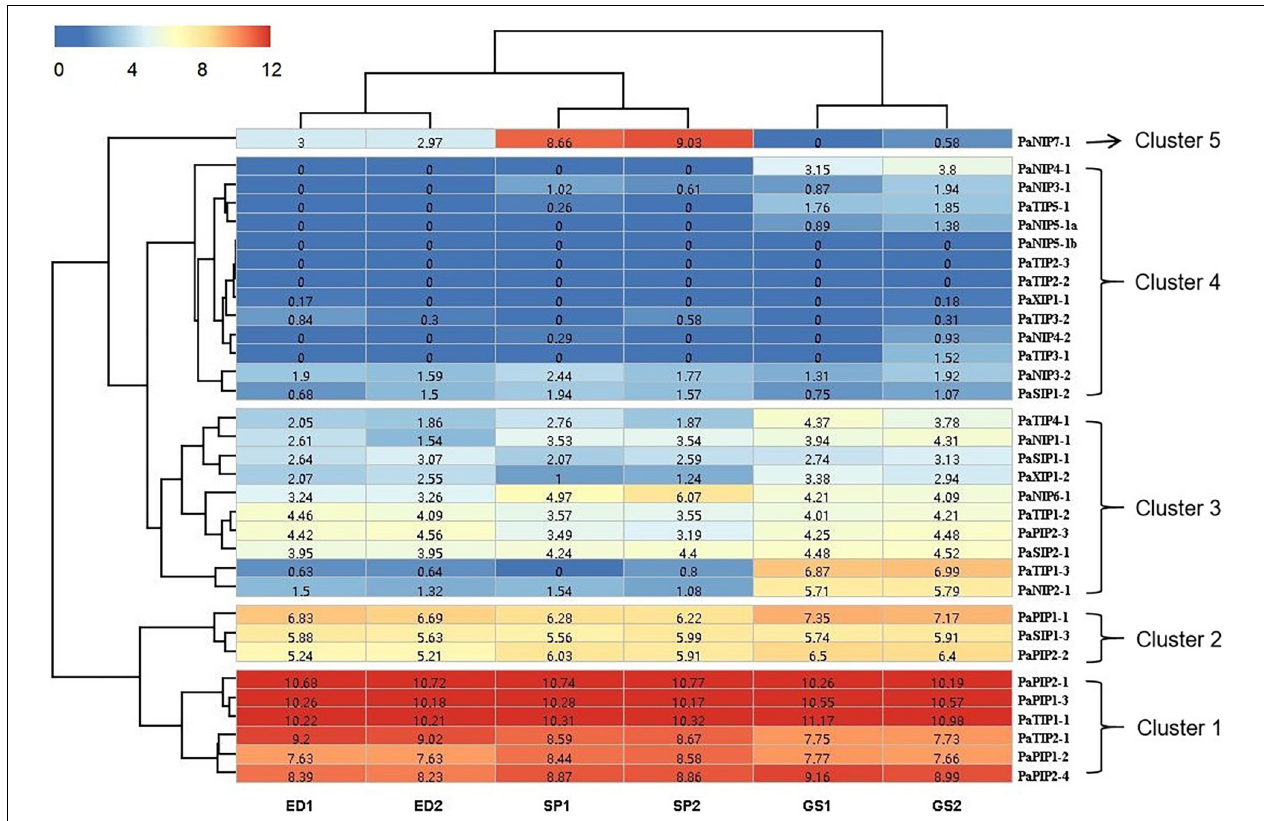
FIGURE 3 | Expression profiles of PaAQPs at different developmental stages based on RNA-seq data. ED, SP, and GS indicate that the tested materials were collected during ecological dormancy, the sprouting period, and germination stage of P. armeniaca, respectively. The number in the middle of each box represents the